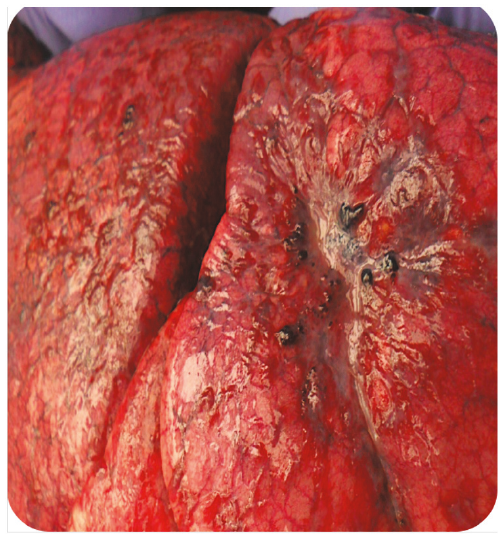
Figure 6: Postmortem finding: hepatization of the lung.